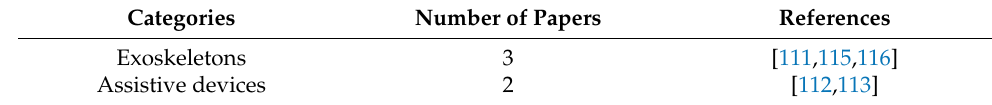
Table 4. Selected paper distribution based on the type of